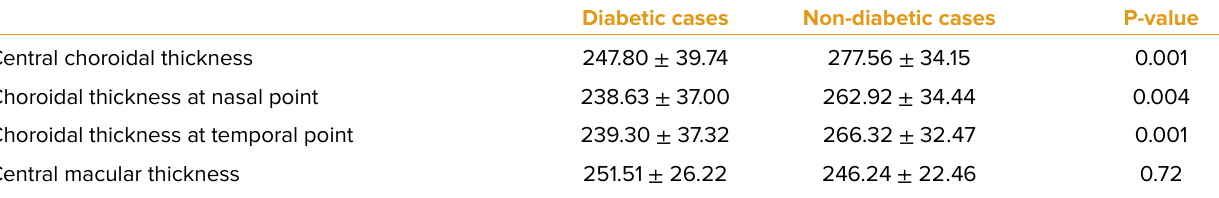
Table 2. Comparison of choroidal and central macular thickness between diabetic and non-diabetic subjects Diabetic cases Non-diabetic